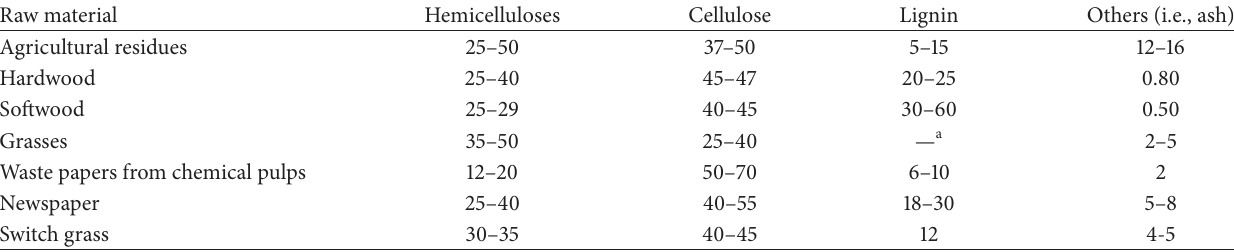
Table 3: Potential lignocellulosic biomass sources and compositions (% dry weight) [86, 87].